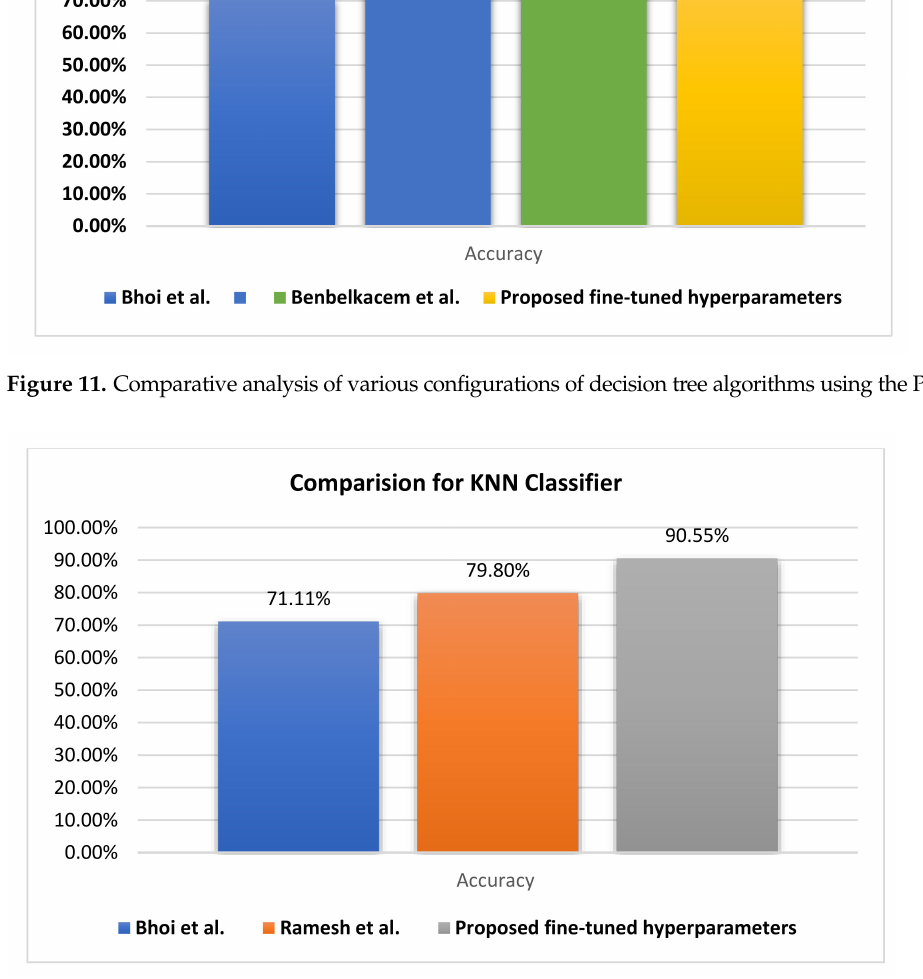
Figure 12. Comparative analysis for various configurations of KNN using the